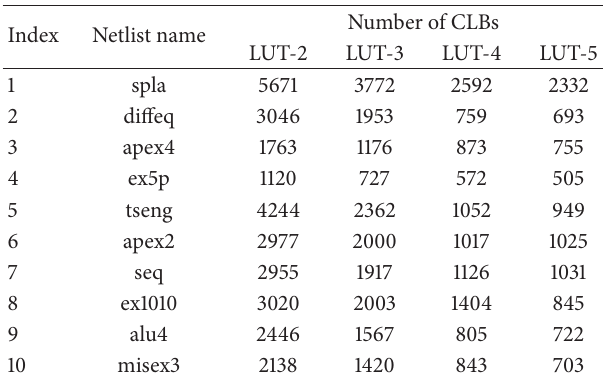
Table 1: MCNC benchmark circuits